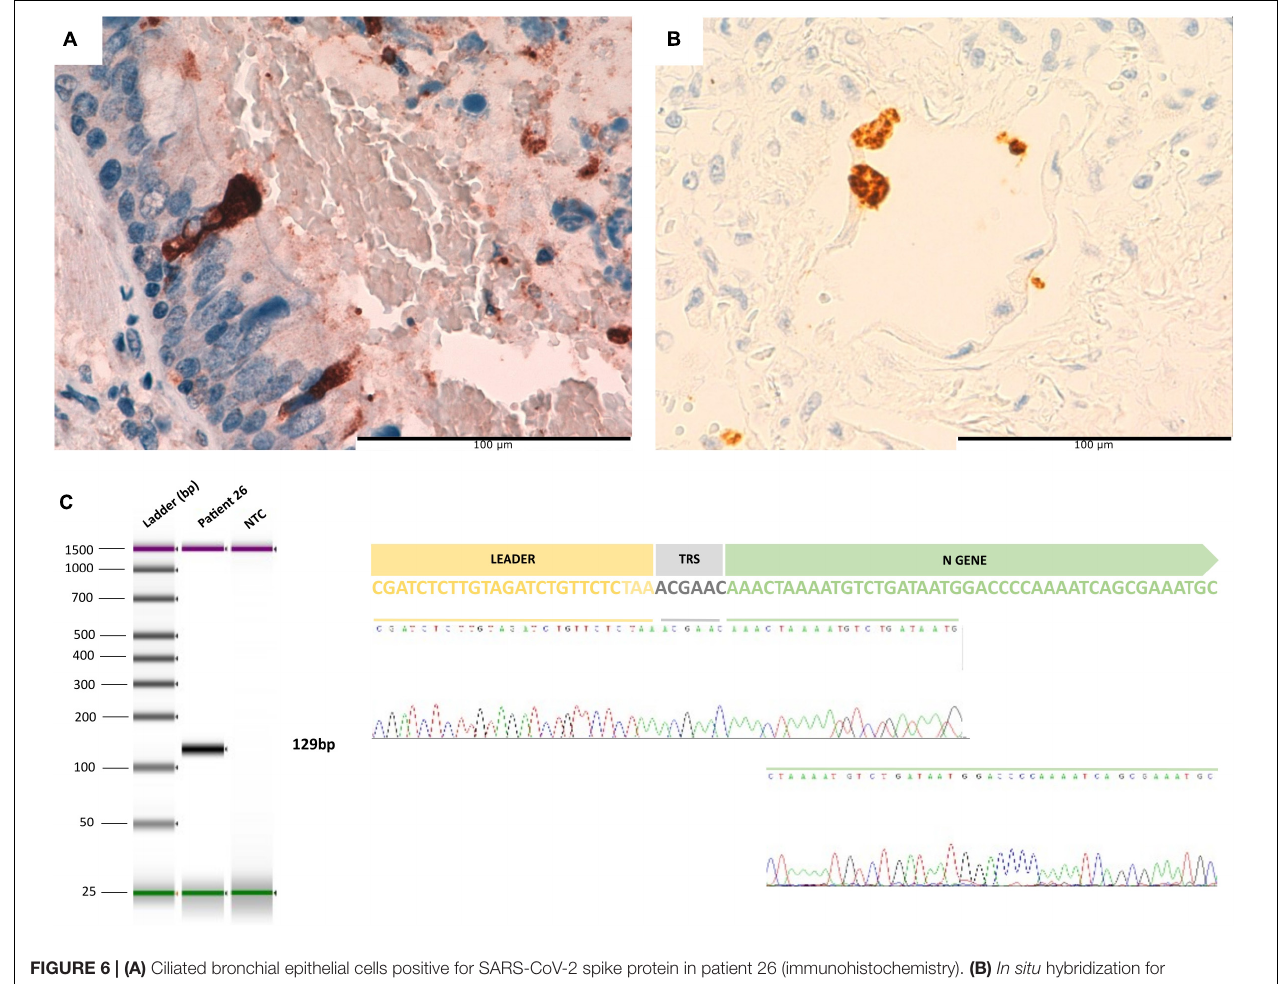
FIGURE 6 | (A) Ciliated bronchial epithelial cells positive for SARS-CoV-2 spike protein in patient 26 (immunohistochemistry). (B) In situ hybridization for SARS-CoV-2 RNA revealed positivity in the cytoplasm of several alveolar cells. (C) From left to right: Tape Station report of sgRNA amplification in infant patient. Electropherogram obtained by Sanger sequencing of the amplified product of gRNA where the leader sequence is observed close to the N